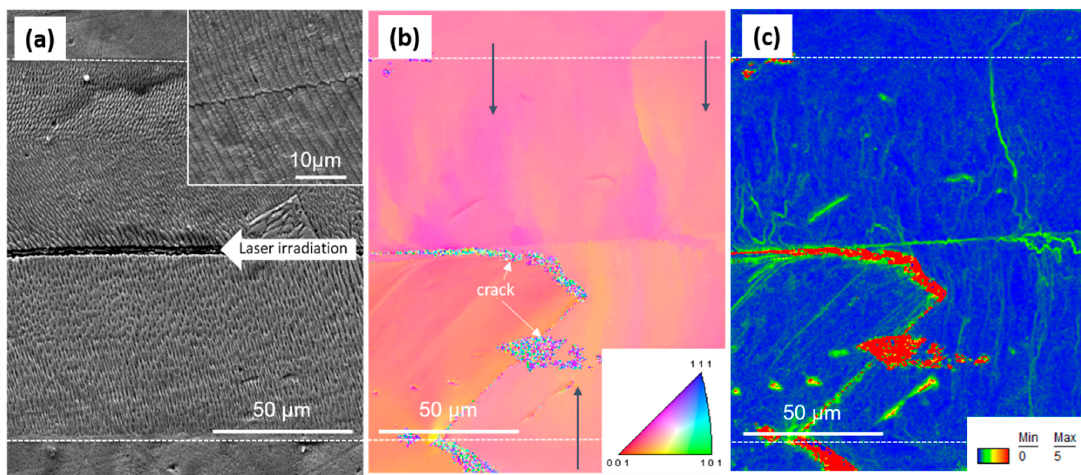
Figure 4. ( a ) Surface FESEM micrograph, ( b ) inverse pole figure (IPF) map, and ( c ) kernel average misorientation (KAM) map obtained via EBSD analysis for the Ni-9 at.% Al-16 at.% V alloy specimen linearly laser-irradiated at a scan speed of 2000 mm/s. The dotted lines indicate the interface between the substrate and traces of the molten pool. The inset in Figure 4a presents a magnified FESEM micrograph from the laser scanned region. The arrows in ( b ) indicate the solidification direction after laser scanning.